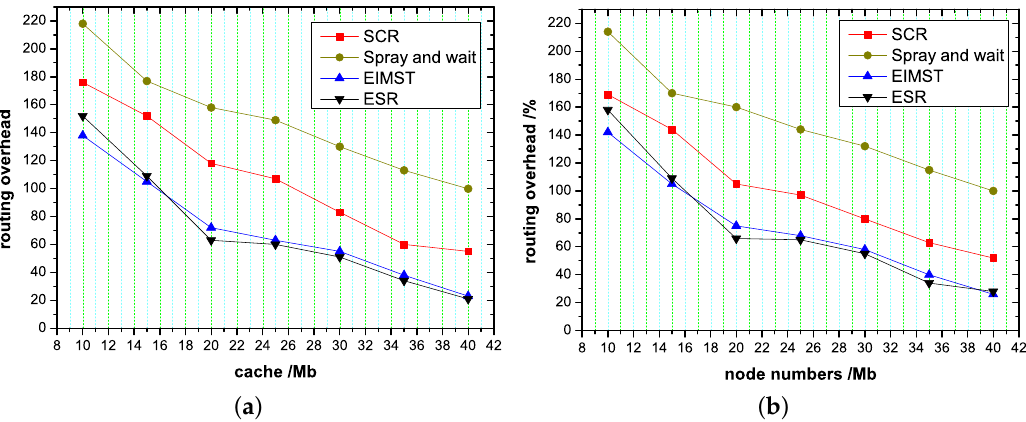
Figure 7. The average routing overhead of the ESR algorithm, EIMST algorithm, Spray and wait algorithm and SCR algorithm when at different node cache sizes and number of nodes. ( a ) The effect of node cache on routing overhead; ( b ) The effect of node cache on routing